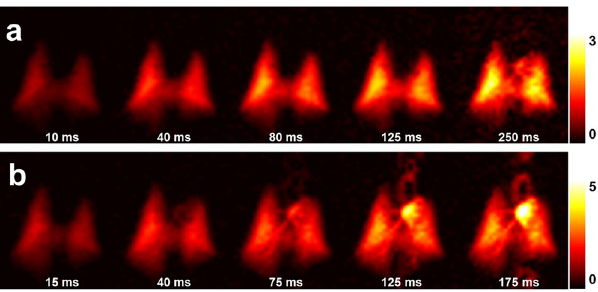
Figure 2. DP xenon accumulation as a function of TR. ( a ) For a DP flip angle of 75°, the DP xenon signal increases throughout the parenchyma as the spacing between RF pulses is lengthened. For a TR of 250 ms, xenon has been transported from the alveolar exchange sites all the way to the left side of the heart. ( b ) A lower DP flip angle of 40° results in reduced depolarization of the DP xenon signal by each RF pulse such that the downstream DP signal accumulates more rapidly. For TRs of 125 ms or more, the aortic arch and possibly the descending aorta become